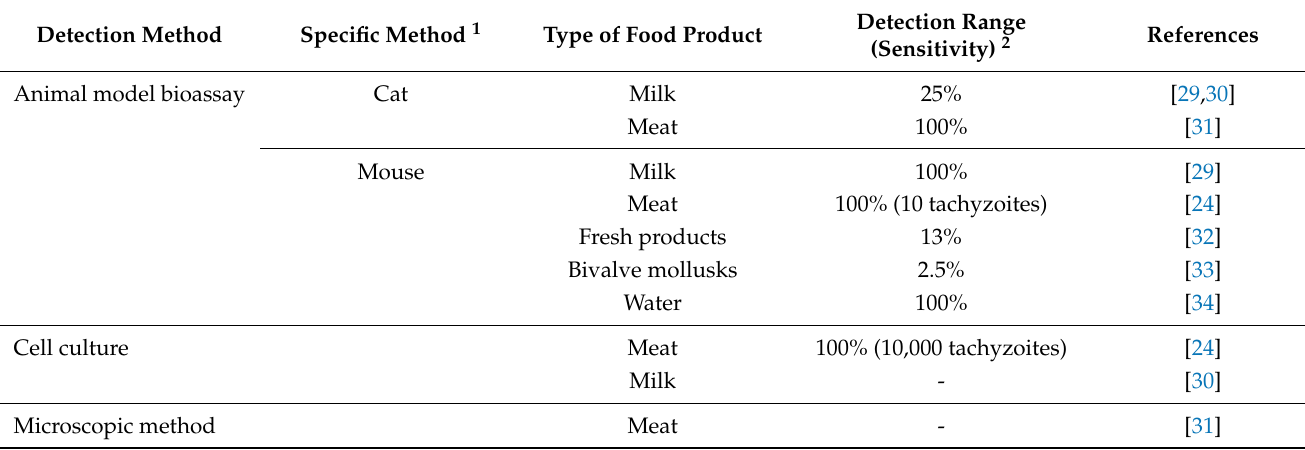
Table 1. The table shows different methods for T. gondii detection, sensitivity of method, and type of food product where this method has been